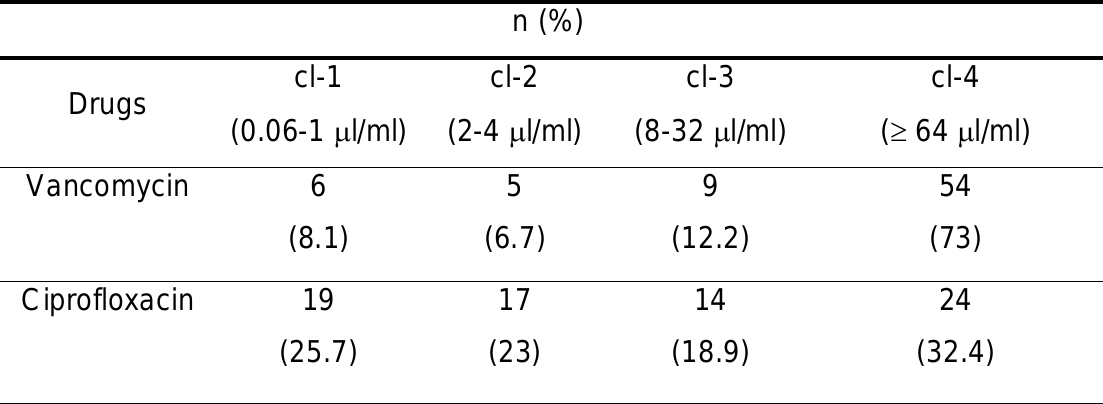
Table 2. Susceptibility of 74 Enterococcus faecalis strains in four classes of MBC ( µ g/ml).